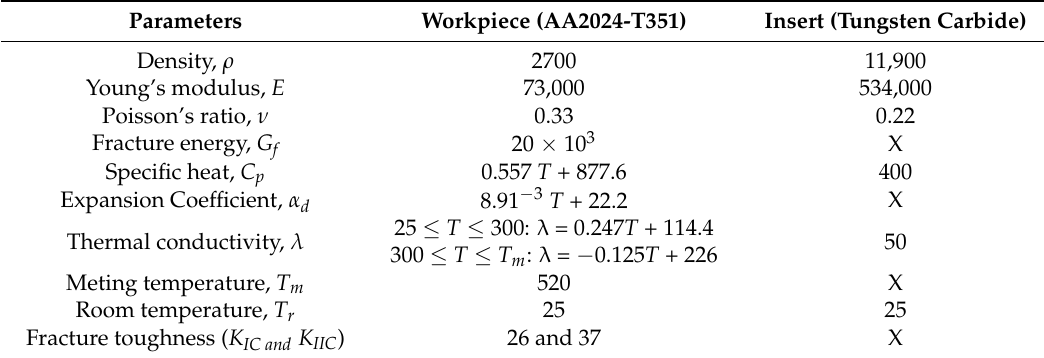
Table 1. Physical properties of tool and workpiece materials [24].